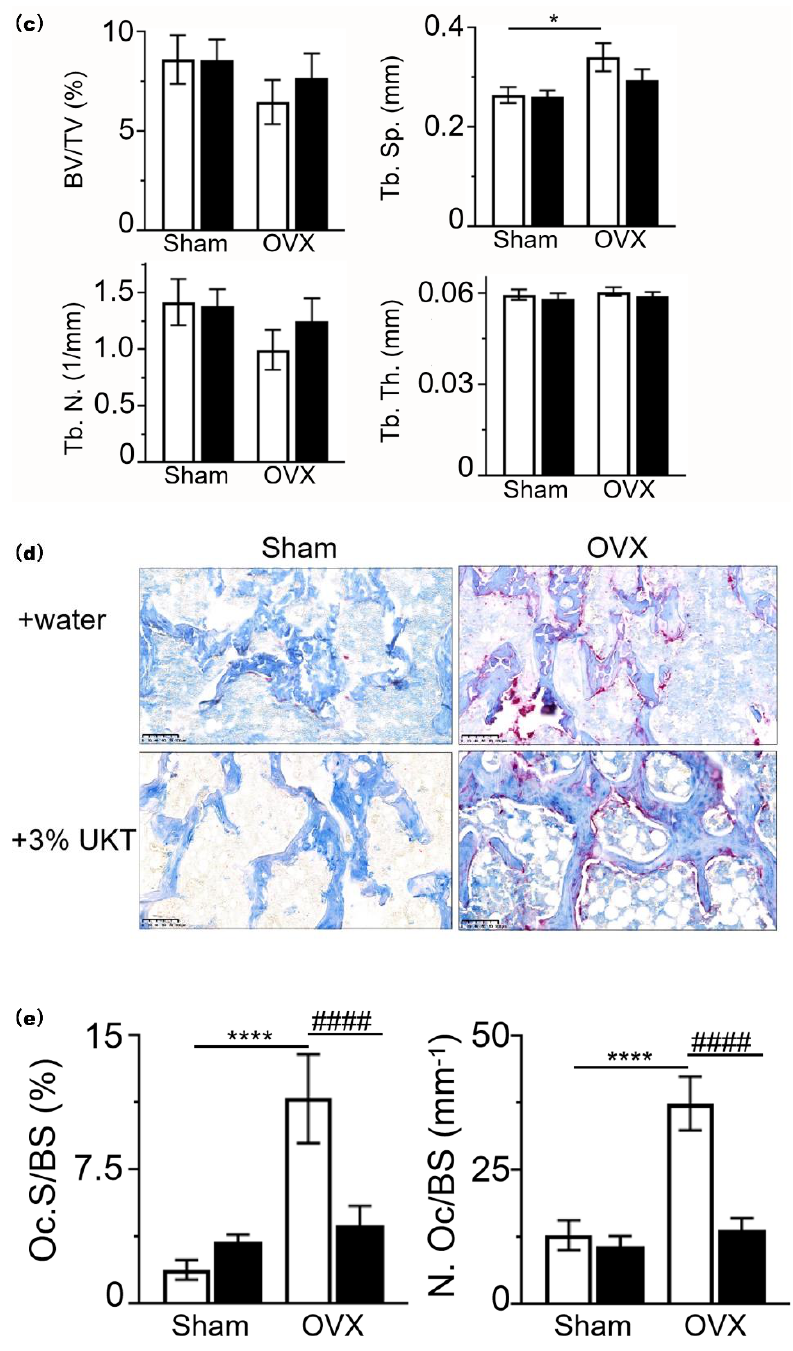
Figure 6. Oral administration of Unkeito (UKT) prevents bone loss in ovariectomy (OVX) mice. Eight-week-old CD-1 mice were daily administrated UKT in drinking water for 28 consecutive days, following sham or OVX operation (sham + water, n = 11; sham + 3% UKT, n = 11; OVX + water, n = 11; OVX + 3% UKT, n = 11). Open bar represents mice with water, while closed bar represents mice treated with 3% UKT. ( a ) Average of body weight and uterus wet weight on day 28 after surgery. ( b ) Images of the distal femur from micro-computed tomography analysis and quantitative data of BV/TV (%), Tb.Sp (mm), Tb.N (1/mm), and Tb.Th (mm) are shown in ( c ). ( d ) Typical pictures of the distal femur from aniline blue and tartrate-resistant acid phosphatase stains, and quantitative data of Oc.S/BS (%) and N.Oc/BS (mm −1 ) are shown in ( e ). Two-way ANOVA was used, followed by Tukey’s multiple comparison tests. Data are expressed as means ± standard error of mean for each group. * p < 0.05, ** p < 0.01, **** p < 0.0001 vs. sham-operated mice with water. ## p < 0.01, #### p < 0.0001 vs. OVX-operated mice with water. Bar = 100 µm. BV/TV, bone volume/tissue volume (bone